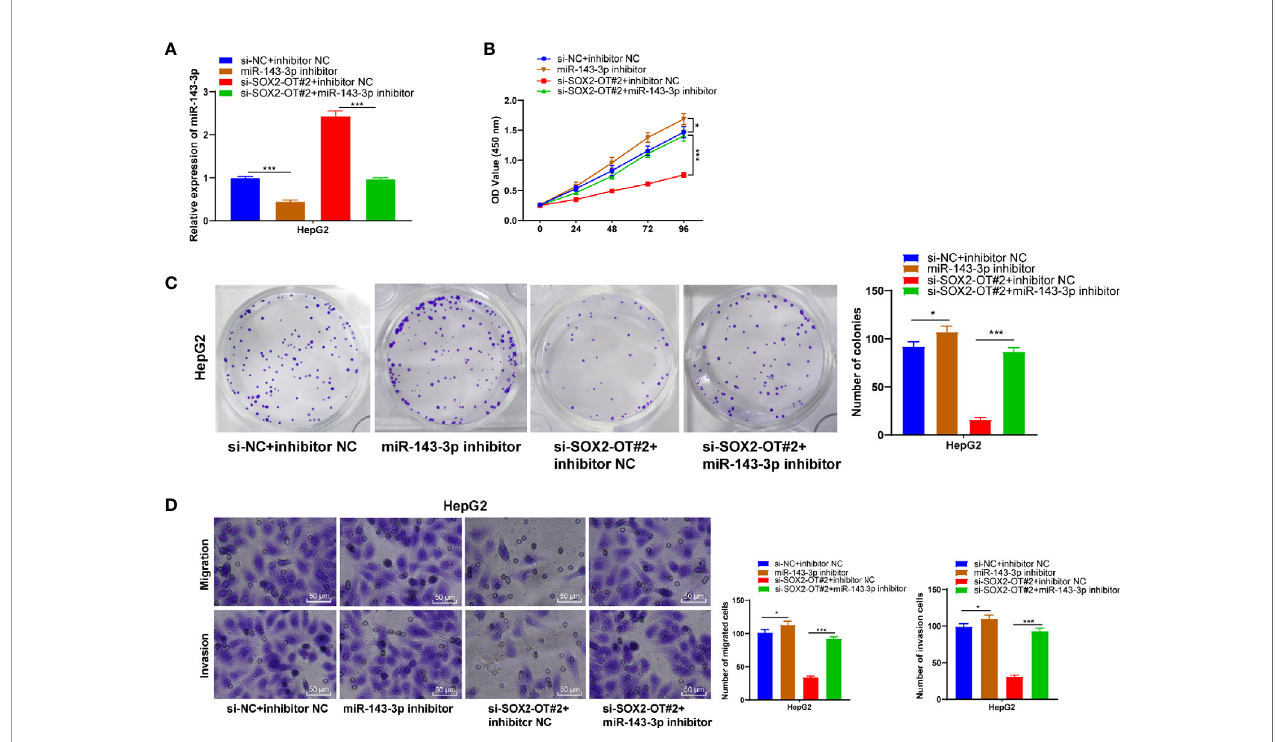
FIGURE 4 | Downregulation of miR-143-3p could reverse the inhibitory effect of si-SOX2-OT on HCC. The miR-143-3p inhibitor was delivered into HepG2 cells with si-SOX2-OT#2, and the cells with si-NC+inhibitor-NC were used as controls. Then, (A) RT-qPCR was used to verify the intervention effect of miR-143-3p inhibitor; (B) CCK-8, (C) colony formation assay, and (D) Transwell assays were used to assess the proliferation, invasion, and migration of cells. The cell experiment was repeated three times independently and data were all metrological data. All data were shown as mean ± standard deviation. One-way ANOVA was used for data analysis, followed by Tukey ’ s test. * P < 0.05, *** P <